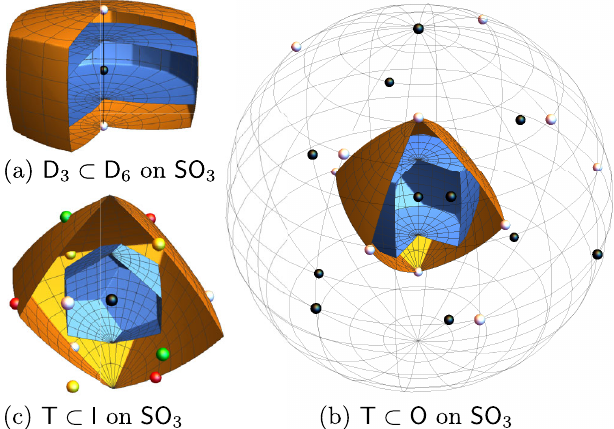
FIG. 4. Non-Abelian subgroup codes. (a) Sketch of the prism spaces SO 3 = D 3 (orange), SO 3 = D 6 (blue), and group elements representing the two logical code words within SO 3 = D 3 for the D 3 ⊂ D 6 dihedral code from Sec. V D. Similar sketches for the quotient spaces (see Table I) and code words of (b) the T ⊂ O and (c) the T ⊂ I codes from Sec. V